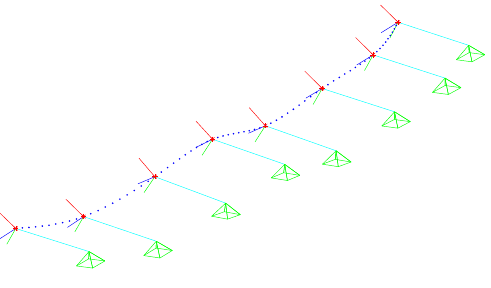
Figure 4. Initial trajectory by spline computation